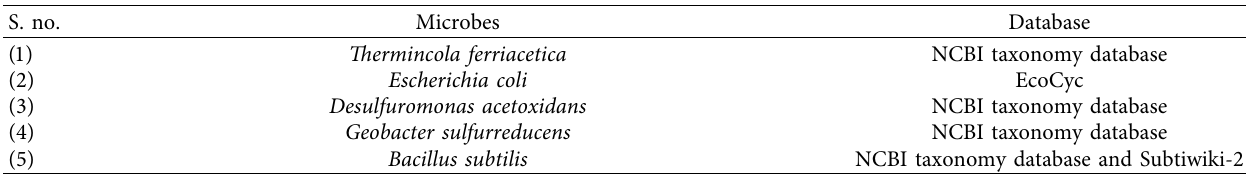
Table 1: Microbes and its